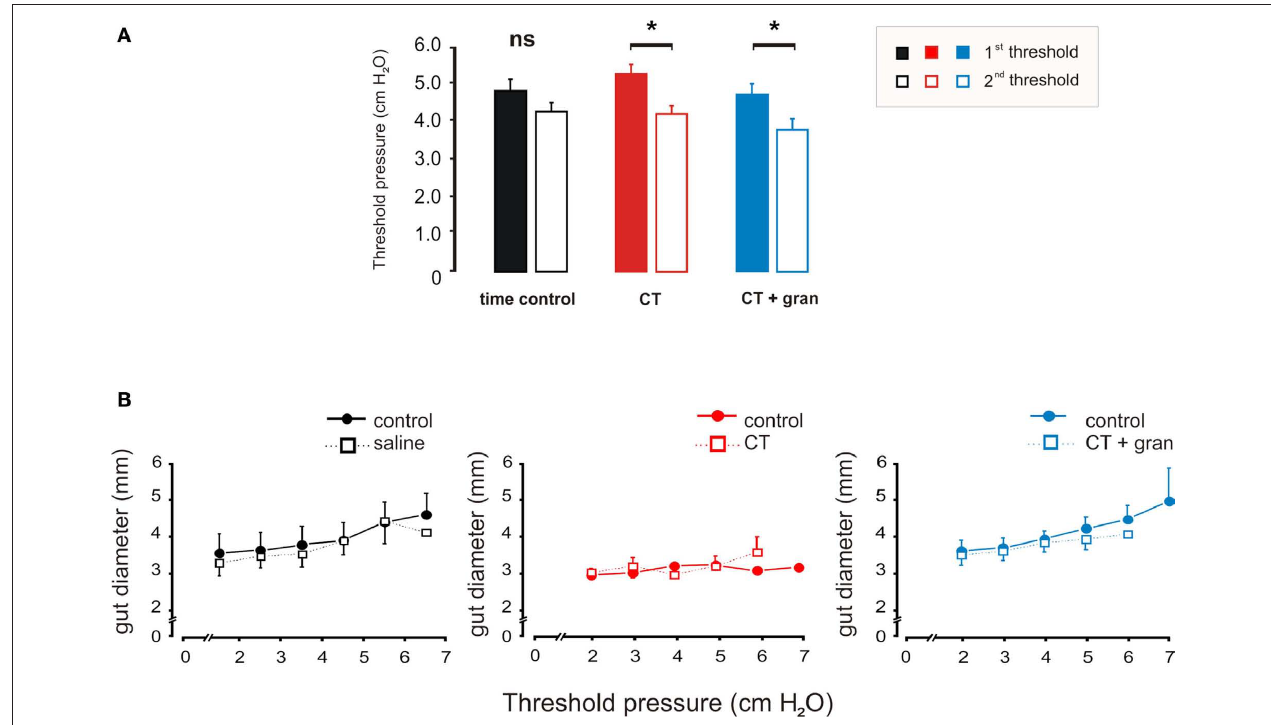
control (black), CT (1.25 μg/ml, red) and CT (1.25 μg/ml) plus granisetron (1 μM, blue). (B) Curves showing the diameter changes produced by each pressure set prior to exposure and after 85 min of exposure. * P <